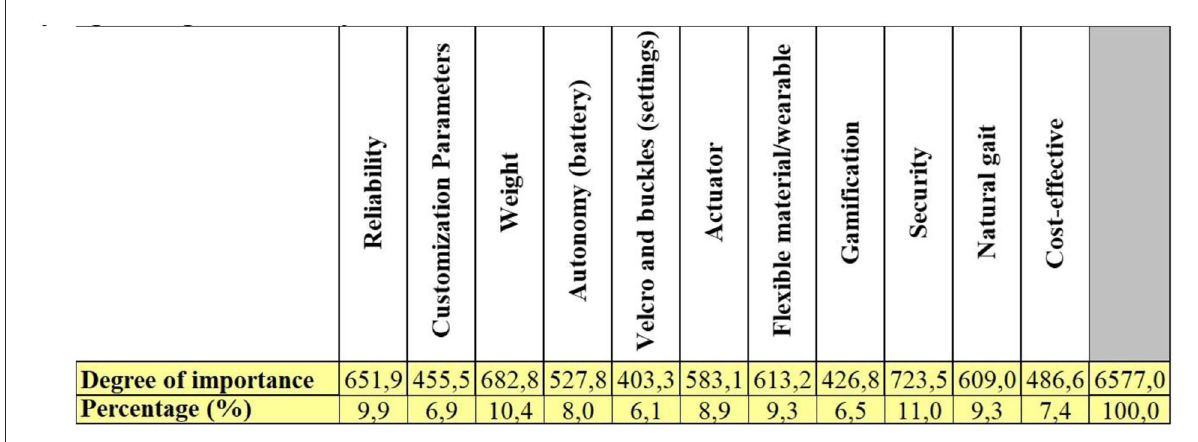
FIGURE5 Main features that the G-Exos should meet obtained according to the results of the QFD